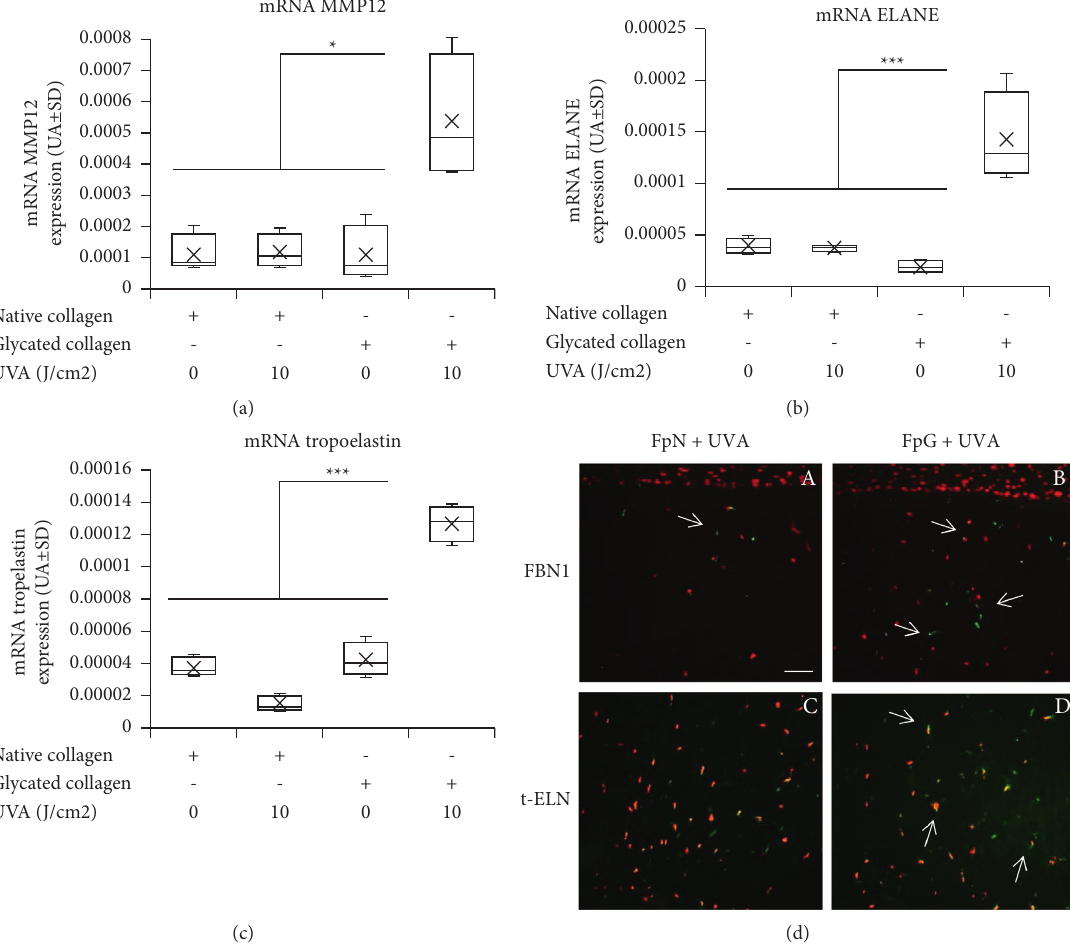
Figure 3: AGEs and UVA irradiation change the elastic network homeostasis and promote an environment in favor of elastosis. mRNA MMP12 (a), elastase (ELANE) (b), and tropoelastin (ELN) (c) expression measured in dermal layers of reconstructed skin made with papillary fibroblasts and native or glycated collagen with or without UVA irradiation (0, 10J/cm 2 ); immunostainings (d) of fibrillin-1 (A, C) and tropoelastin (B, D) of skin reconstructed containing papillary fibroblasts (Fp) (A to D) using native collagen (A, B) or glycated collagen (C, D) after UVA irradiation (10J/cm 2 ). Note that glycation stimulates tropoelastin and fibrillin expression by fibroblasts in 3D culture. mRNA levels were quantified in the dermis (fibroblasts, n � 4) using qPCR at the end of the culture emersion phase. Data are expressed in arbitrary units (AU ± SD � arbitrary units ± standard deviation). Statistics: analysis of variance (ANOVA) adjusted post hoc Tukey–Kramer tests for pairwise comparisons ( ∗ P < 0.05; ∗∗∗ P <